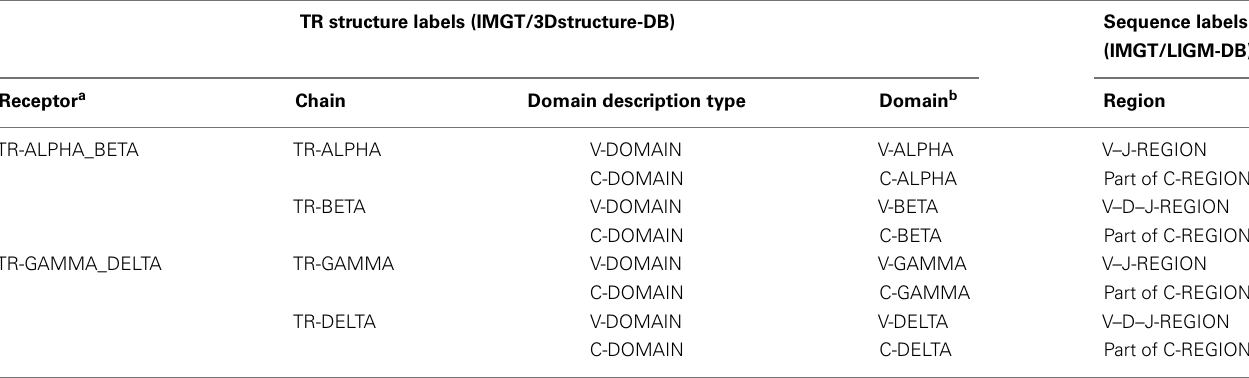
Table 2 |T cell receptor (TR), chain, and domain structure labels and correspondence with sequence labels .